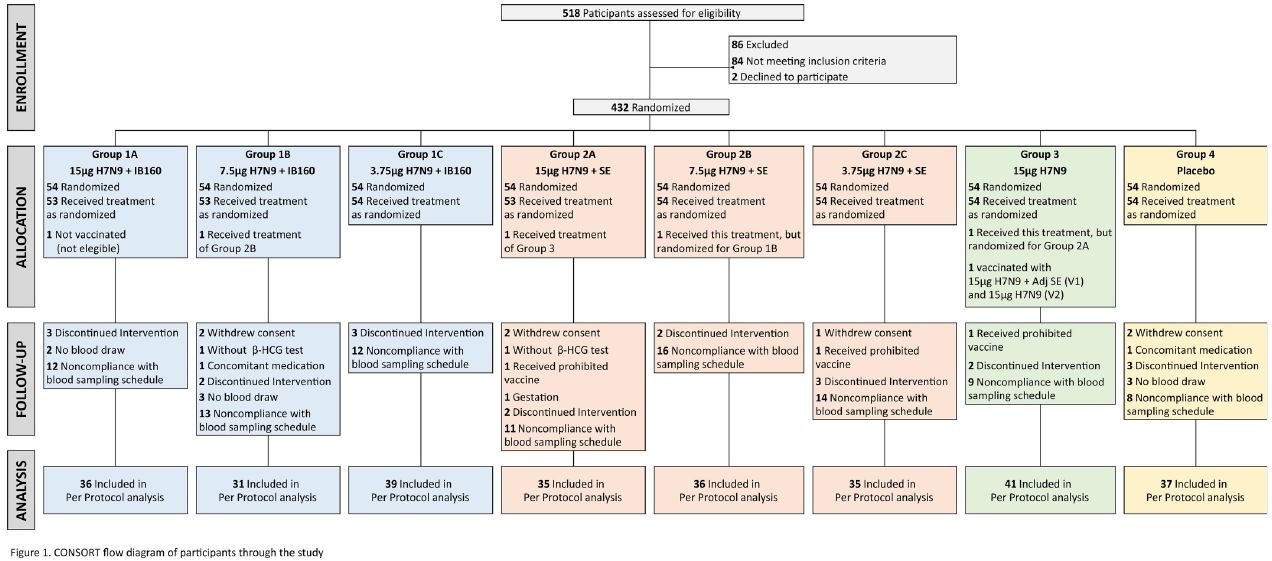
Fig 1. CONSORT flow diagram of participants through the